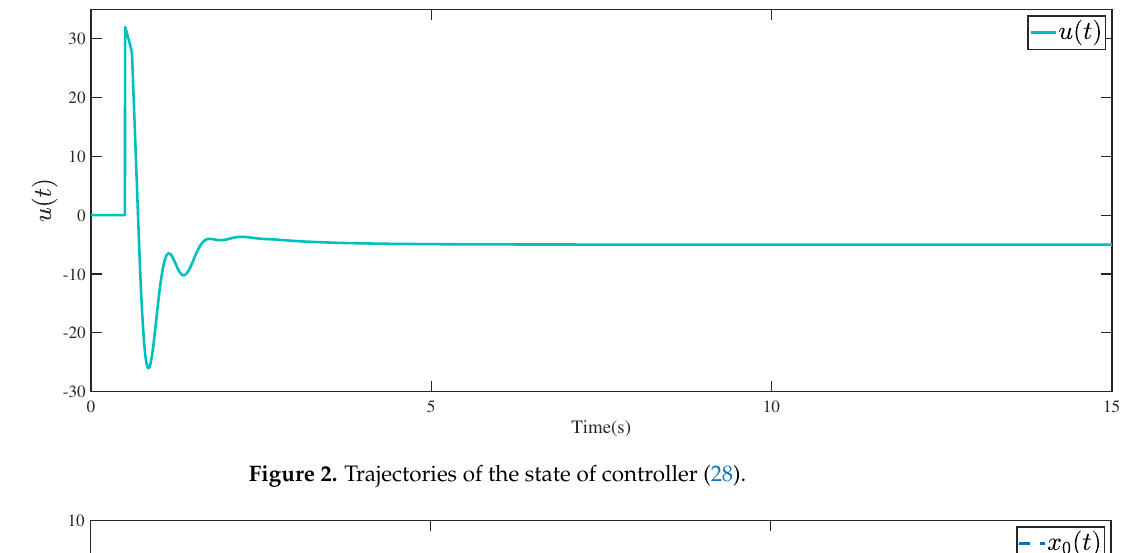
Figure 2. Trajectories of the state of controller (28).